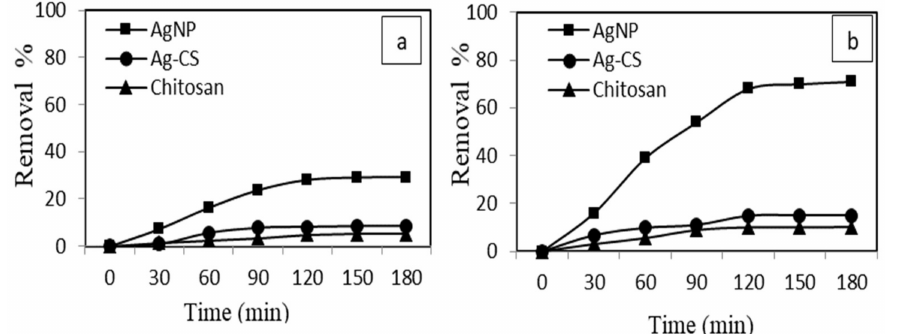
Figure 8. Effect of contact time on ( a ) adsorption and ( b ) sono-adsorption of (MB) using chitosan, AgNPs and AgCS (MB concentration = 5 mg L − 1 , Adsorbent’s concentration = 0.005 g, pH = 6, min, US power 80 W).